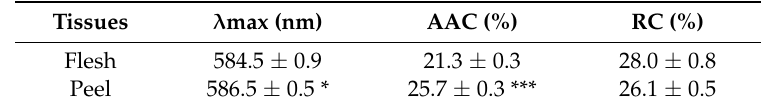
Figure 2. Spectra of iodine absorbance of starches. Table 2. Maximum absorption wavelengths ( λ max), apparent amylose contents (AAC), and relative crystallinities (RC) of starches.